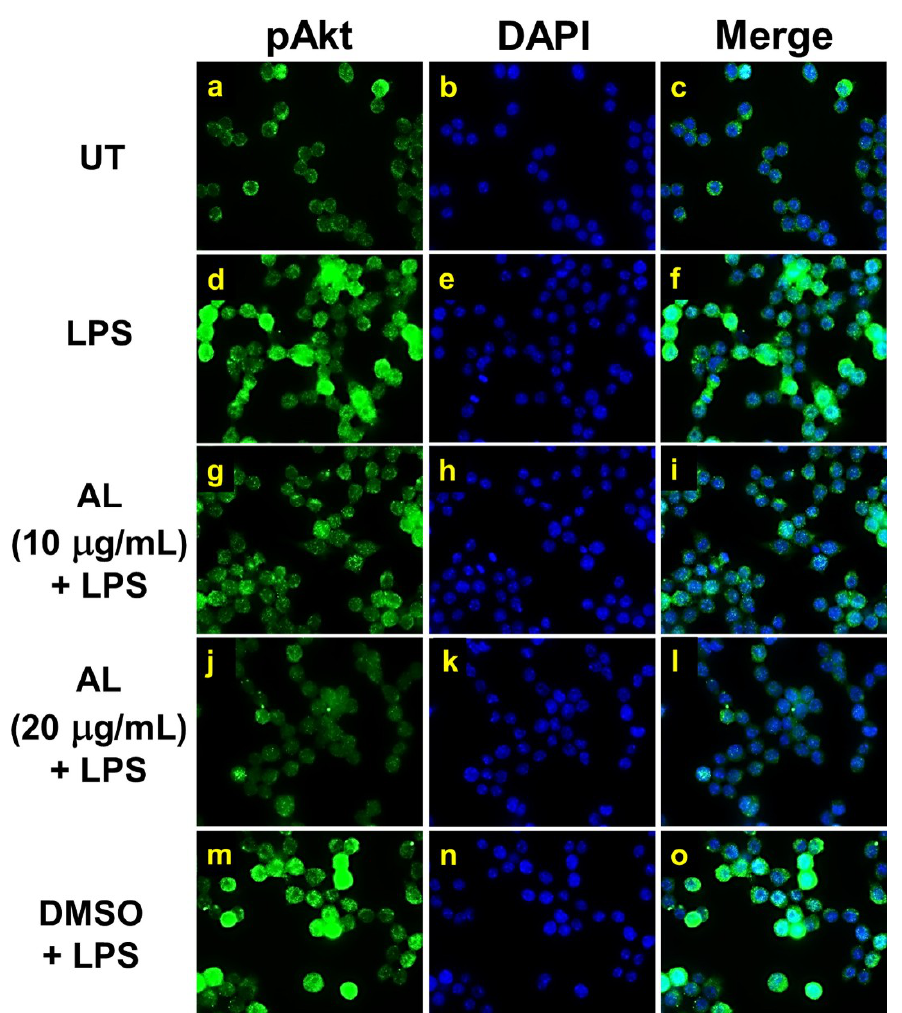
Figure 8. The inhibitory effects of AL extract on Akt phosphorylation in response to LPS induction in RAW 264.7 cells. Representative images from immunofluorescence study showing Akt phosphorylation at Ser473 (green) of untreated cells ( a – c ), LPS stimulated cells ( d – f ), LPS-stimulated cells with the presence of AL extract at 10 µg/mL ( g – i ) or 20 µg/mL ( j - l ), or DMSO ( m – o ). Nuclei (blue) were stained with DAPI. The micrographs were captured at 100× magnification, and data are representatives of three replicates.